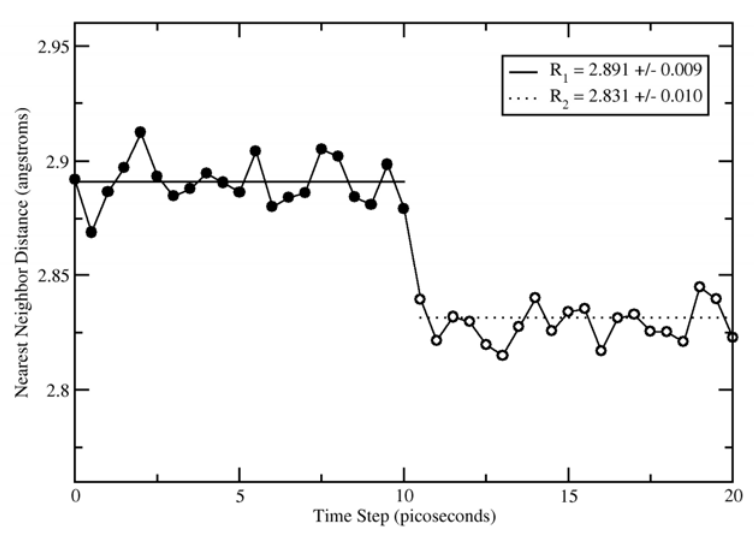
Figure 1. A plot of first-nearest neighbor distance from center of an atom (or void), versus simulation time steps in molecular dynamic simulations. Filled black circles indicated a full lattice and open circles indicate a vacancy, where the atom is removed at 10 ps into the data collection run. Average neighbor positions before and after atom removal are 2.891 +/-0.009 and 2.831 +/-0.010,